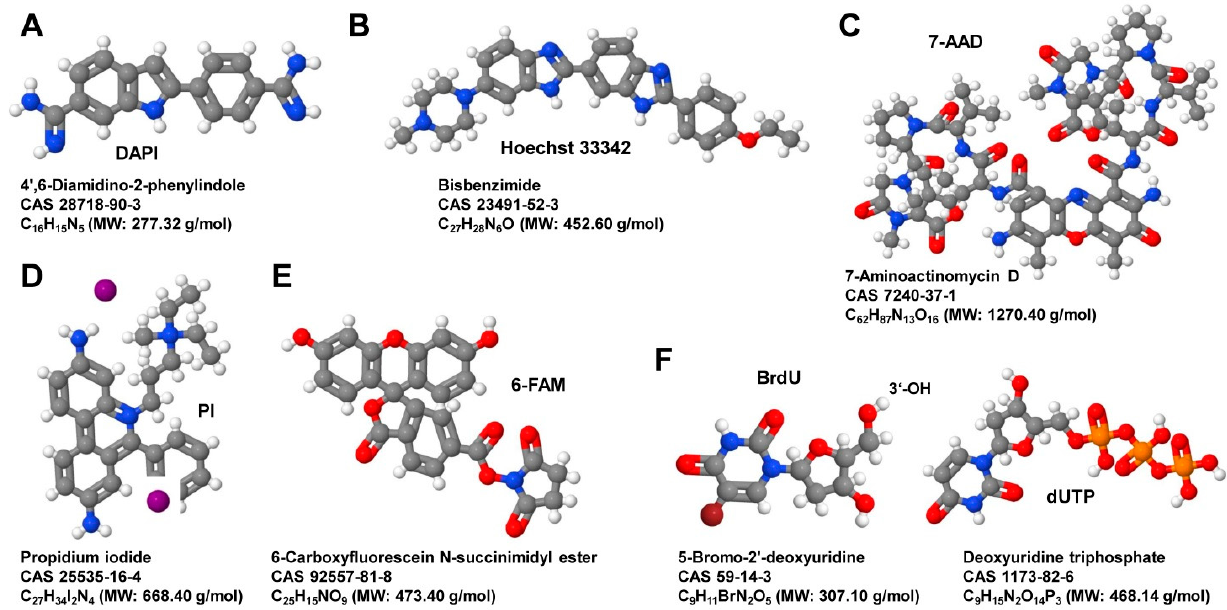
Figure 2. Selection of substances frequently used in FACS analysis. ( A ) 4 ′ ,6-dDiamidino-2-phenylindole (DAPI) is a cell-permeable compound that binds strongly to adenine–thymine-rich regions in DNA. The DAPI-DNA complex has an absorption maximum at a wavelength of 358 nm (ultraviolet) and an emission maximum at 461 nm (blue) that can be detected through a blue/cyan filter. ( B ) Unbound Hoechst 33,342 has a maximum fluorescence emission at 510–540 nm, while this dye emits in ultraviolet light (~350 nm) blue fluorescence with an emission spectrum maximum at 461 nm when bound to double-stranded DNA. ( C ) The fluorescent dye 7-Aminoactinomycin D intercalates primarily in double-stranded DNA with high GC-content. If used for cell staining in FACS, the cell membrane must be permeabilized. It can be best excited with diode lasers at 561 nm resulting in an emission with a maximum of 647 nm. ( D ) Propidium iodide is a not membrane-permeable fluorescent DNA intercalating agent with an excitations maximum of 493 nmg (blue-green), and an emission maximum of 636 nm (red). ( E ) 6-Carboxyfluorescein N -succinimidyl ester is a cell-permeable, amine-reactive fluorescent dye that particularly binds via its succinimidyl group to proteins rich in lysine with an absorption wavelength of 495 nm and an emission wavelength of 517 nm. ( F ) 5-Bromo-2 ′ -deoxyuridine (left) is a nucleotide analog to dUTP (right) that can incorporate in place of thymidine in newly synthesized DNA. The modified DNA can be detected with BrdU-specific antibodies or directly visualized when labeled with flurochormes at its 3 ′ -OH position. All images were generated with the open-source Java viewer Jmol version 14.2.15_2015.07.09 [19].